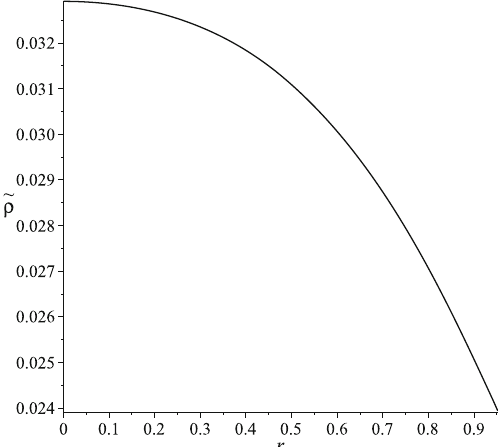
Fig. 20 Energy density for the solution obtained with the second algo- rithm with ˜ F (cid:9)= 0 form the isotropic Gold III solution